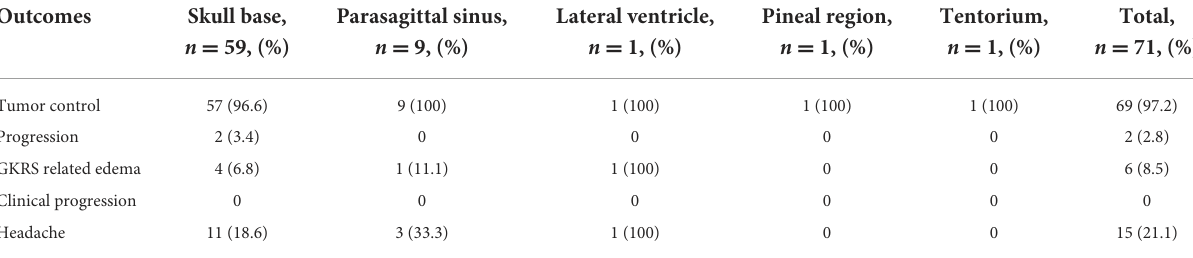
TABLE 3 Outcomes of clinical response and toxicity of dose-staged Gamma Knife for meningiomas in different location.